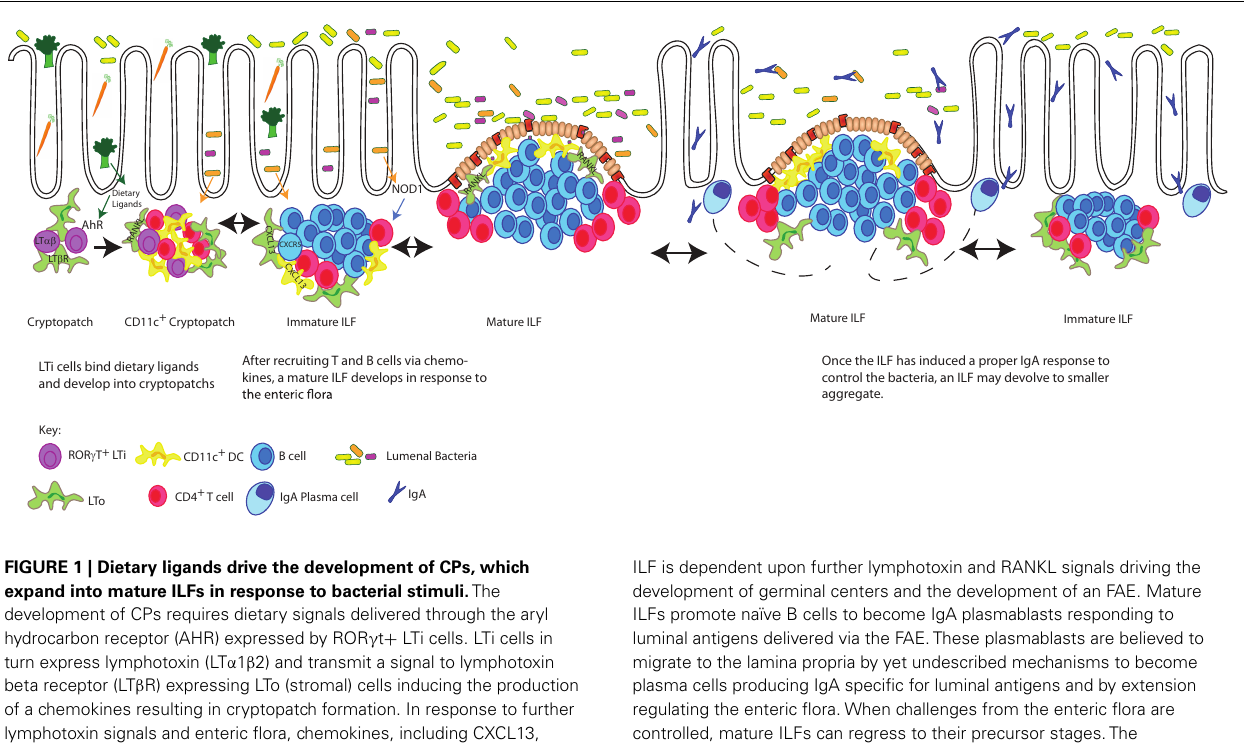
FIGURE 1 | Dietary ligands drive the development of CPs, which expand into mature ILFs in response to bacterial stimuli. The development of CPs requires dietary signals delivered through the aryl hydrocarbon receptor (AHR) expressed by ROR γ t + LTi cells. LTi cells in turn express lymphotoxin (LT α 1 β 2) and transmit a signal to lymphotoxin beta receptor (LT β R) expressing LTo (stromal) cells inducing the production of a chemokines resulting in cryptopatch formation. In response to further lymphotoxin signals and enteric flora, chemokines, including CXCL13, recruit lymphocytes to transform CPs into immature ILFs and subsequently mature ILFs.The transition of an immature ILF to a mature